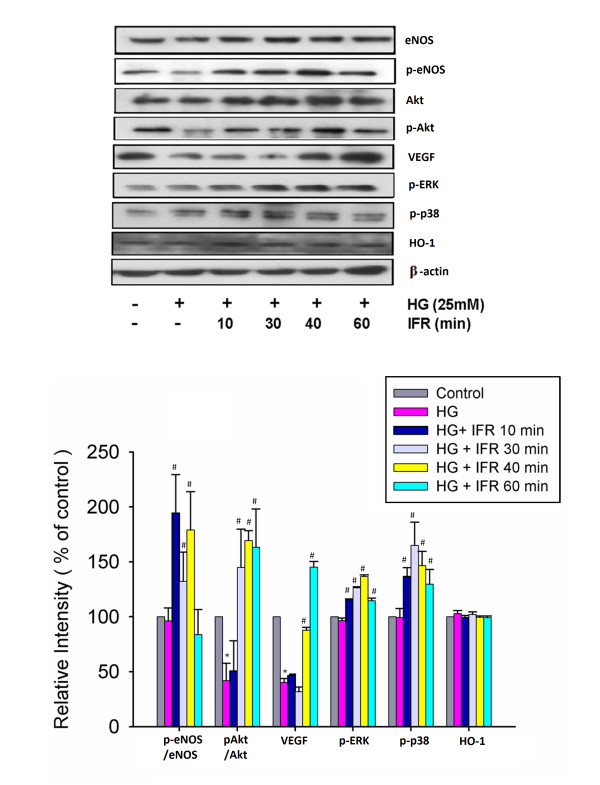
 Effects of IFR radiation on eNOS, Akt, p-ERK, p-38 MAPK, VEGF and HO-1 production in cultured EPCs. Administration of IFR radiation on cultured ECFCs for 10, 30, and 40 min followed by treatment of EPCs in high-glucose conditions significantly upregulated high glucose-impaired eNOS production and eNOS activity (p-eNOS/total eNOS). Treatment of IFR therapy for 30, 40 and 60 min also upregulated Akt activation (p-Akt/total Akt). In addition, administration IFR radiation also promoted VEGF production, p-ERK, and p-38 MAPK in high glucose conditions, but not HO-1. Each bar graph shows the summarized data from four separate experiments by densitometry after normalization. Data are means ± SEM; n = 4 in each experiment. (*p < 0.05 compared with control; #p < 0.05 compared with HG group.).